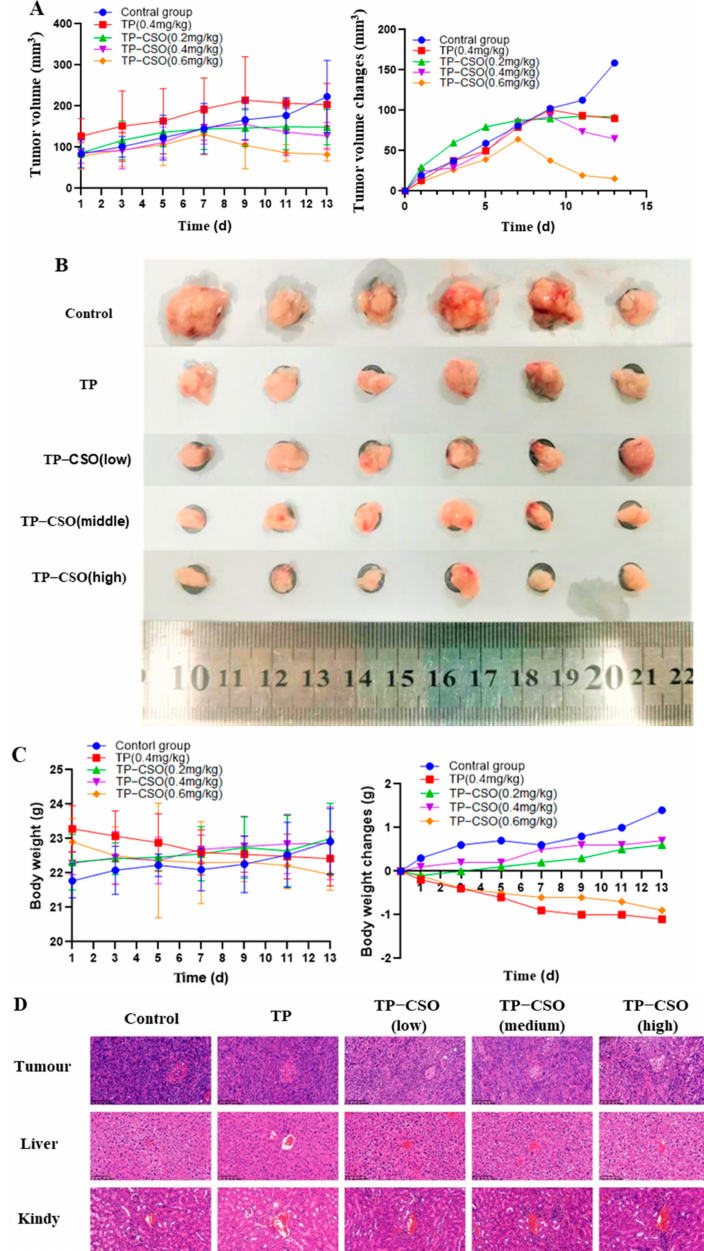
Figure 5. Changes in tumor volume of different drug-treated groups for 14 days ( A ) and on the last day ( B ); mouse body weight change with time ( C ); H&E staining of liver and kidney organs and tumors ( D